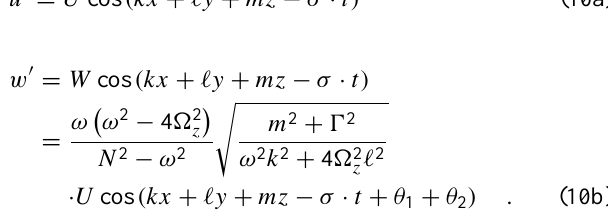
Fig. 8c. Daily average profiles of the inferred acceleration by zonal Fig8c Daily average profiles of the inferred acceleration by zonal momentum flux (upper momentum flux (upper panel) and by meridional momentum flux panel) and by meridional momentum flux (lower panel) in the 10 min- 24h band. The 1 st (lower panel) in the 10min–24h band. The 1st day acceleration were denoted by “circle”, 2nd day fluxes by “line”, and 3rd day by day acceleration were denoted by ‘circle’, 2 nd day fluxes by ‘line’, and 3 rd day by ‘star’. “star”. Notice that the scale of zonal component is 5 times of the Notice that the scale of zonal component is 5 times of the scale of meridional component. scale of meridional